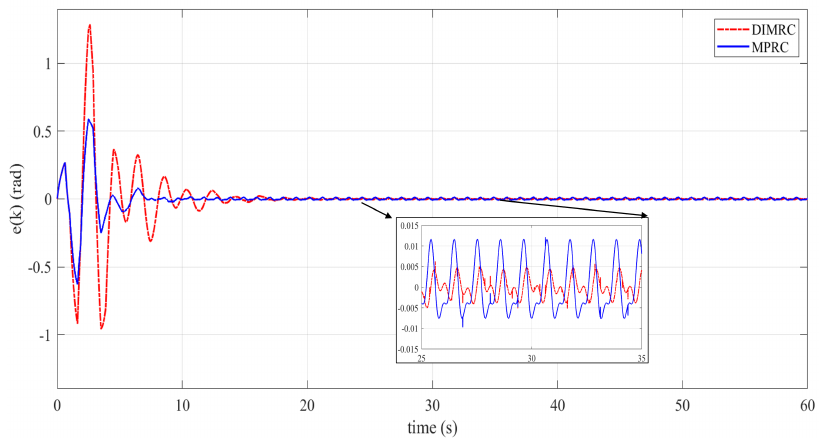
Figure 12. Tracking errors for the non-minimum phase system (42) with the disturbance model v 2 ( t ) .